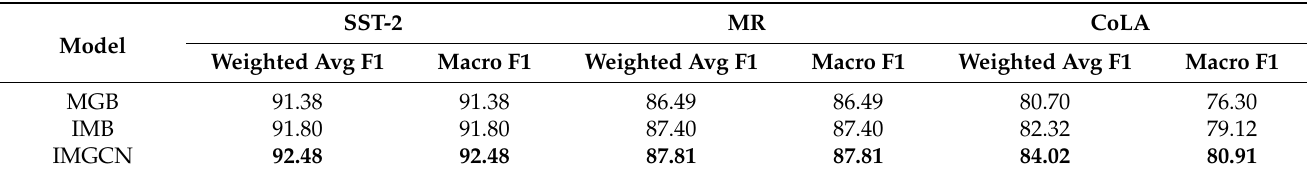
Table 2. Experimental results of ablation study.